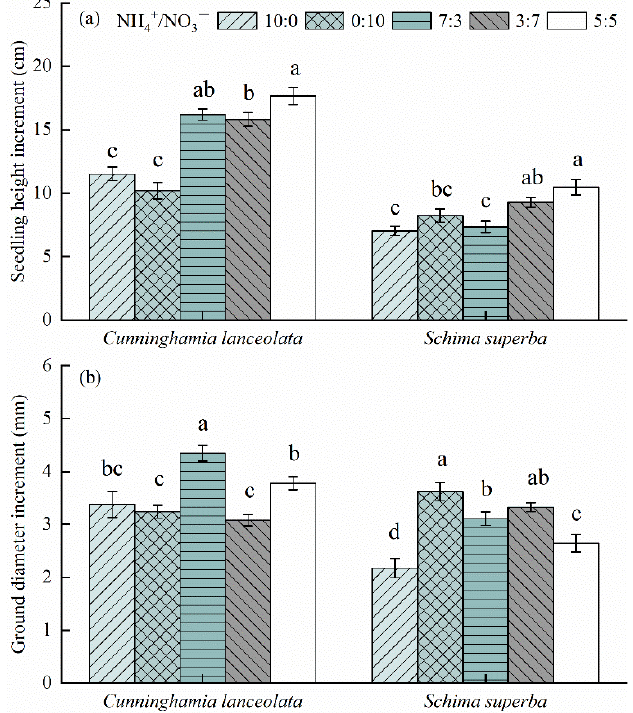
Figure 4. Effects of different NH 4+ -N and NO 3 − -N ratios on Δ H ( a ) and Δ GD ( b ). Data are expressed as the mean ± standard error (SE). Different lowercase letters on the columns indicate significant differences among the treatments.